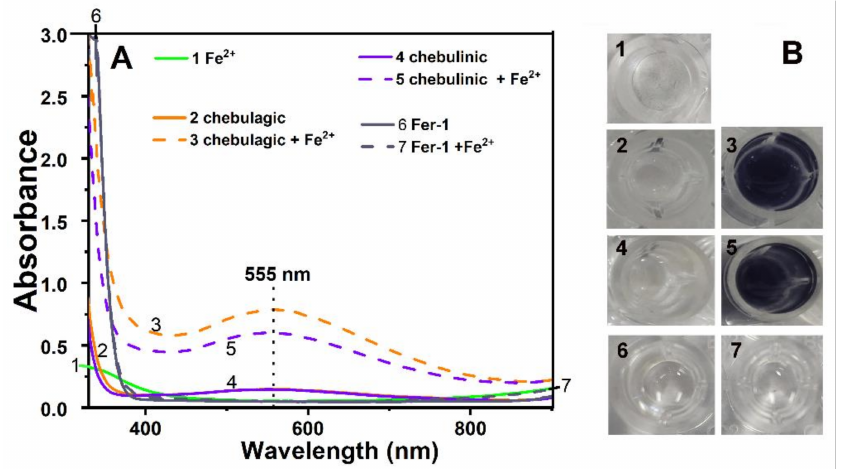
Figure 5. ( A ) Visible light spectra of high concentrations of chebulagic acid, chebulagic acid/iron(II), chebulinic acid, and chebulinic acid/iron(II); ( B ) colors of the various solutions. 1, 50.3 mM iron (II); 2, 0.3 mM chebulagic acid; 3, 0.3 mM chebulagic acid + 50.3 mM iron(II); 4, 0.3 mM chebulinic acid; 5, 0.3 mM chebulinic acid + 50.3 mM iron(II); 6, 0.3 mM Fer-1; 7, 0.3 mM Fer-1 + 50.3 mM